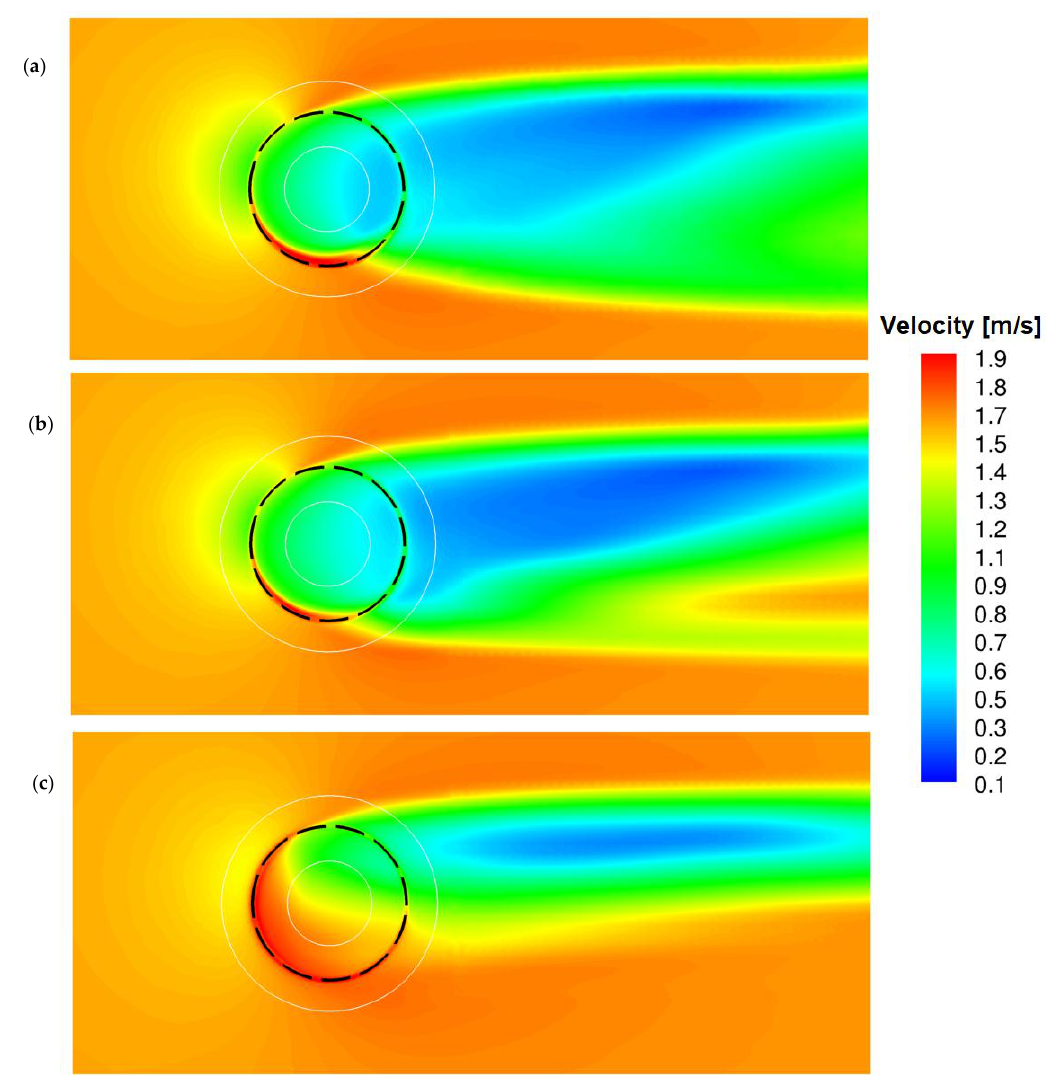
Figure 14. Averaged velocity field in three horizontal planes ( a ) y / H = 0.1, ( b ) y / H = 0.5, ( c ) y / H = 1.0. The dashed black line represents the circle described by the blades chord and the solid white lines delimitate the inner and outer boundaries of the rotating ring. Flow is from left to right.